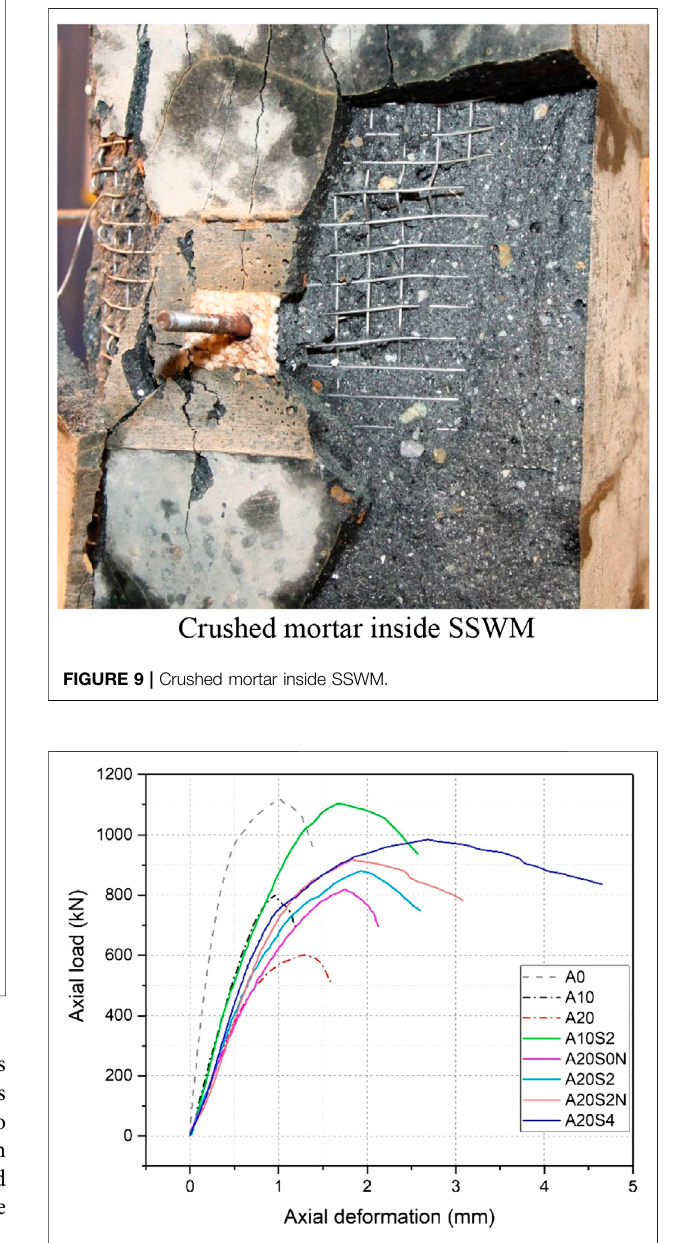
FIGURE 10 | Load – deformation relationships of specimens under axial